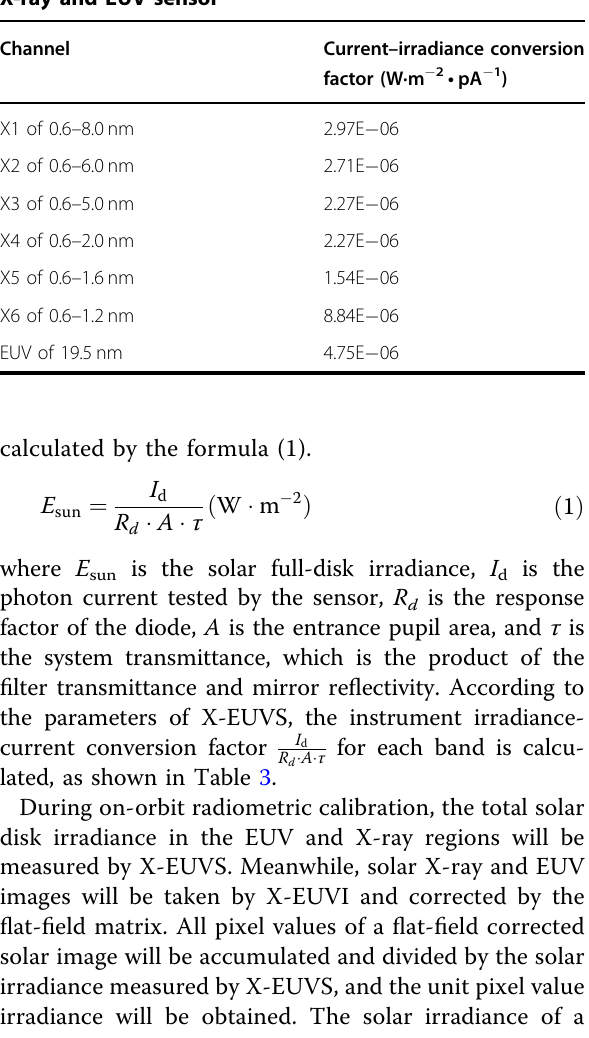
Residuals-x, residuals-y (after image stabilization)